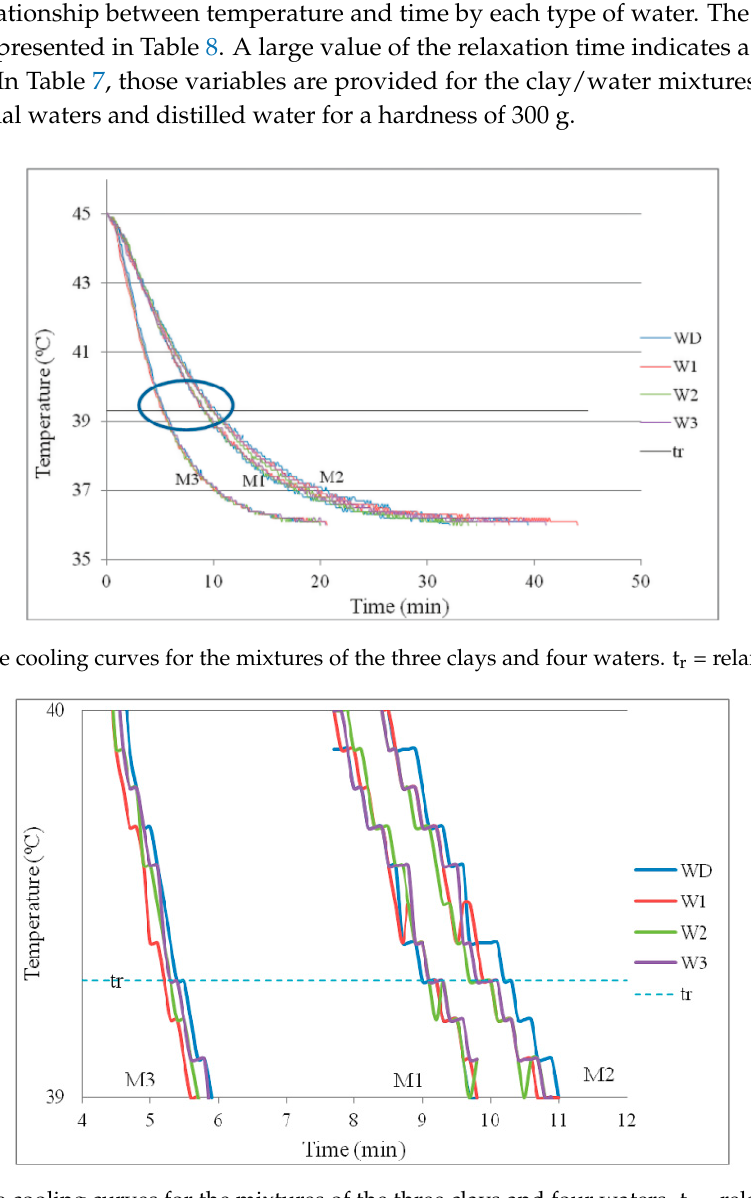
Figure 7. The cooling curves for the mixtures of the three clays and four waters. t r = relaxation time (extension of the area marked with oval).